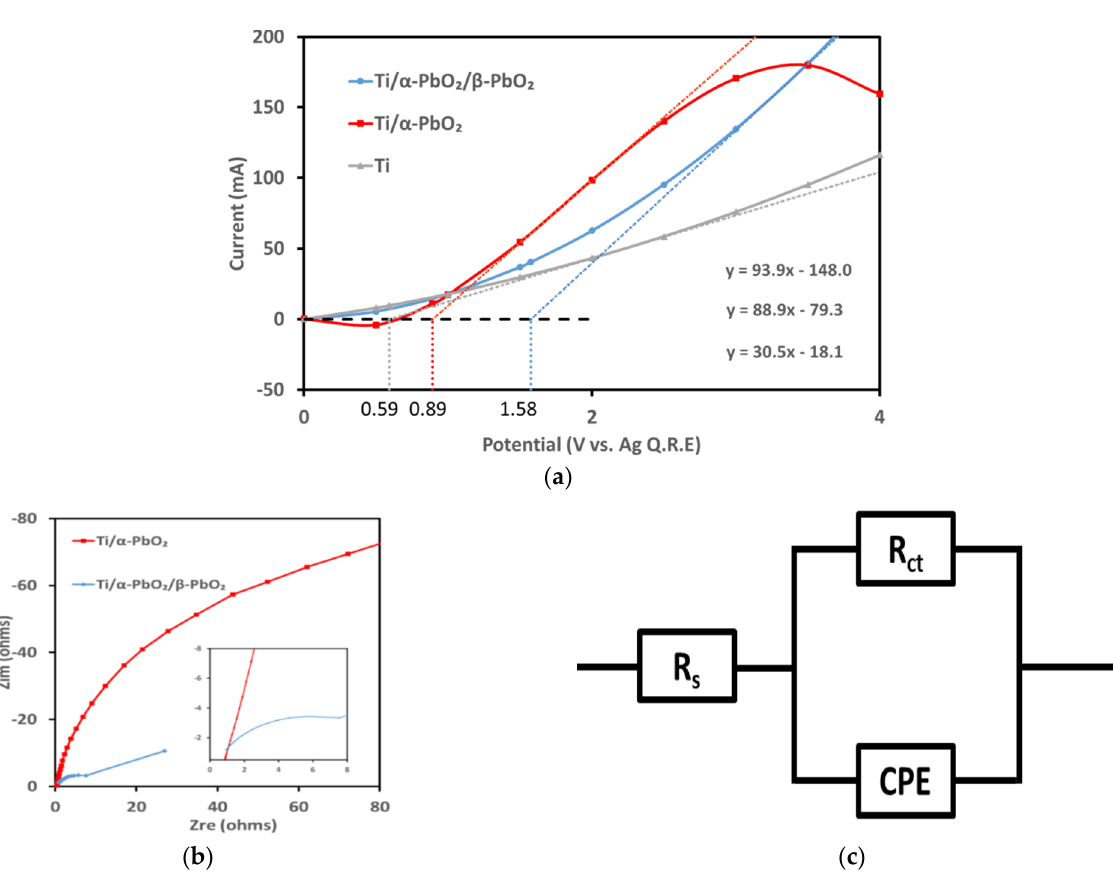
Figure 4. ( a ) Polarization curves in 0.50 mol L − 1 Na 2 SO 4 at scan rate of 2 mV s –1 . ( b ) Electrochemical impedance spectros- copy in 0.50 mol L − 1 Na 2 SO 4 with frequency range of 10 5 ~10 –1 Hz. ( c ) Randles equivalent circuit.